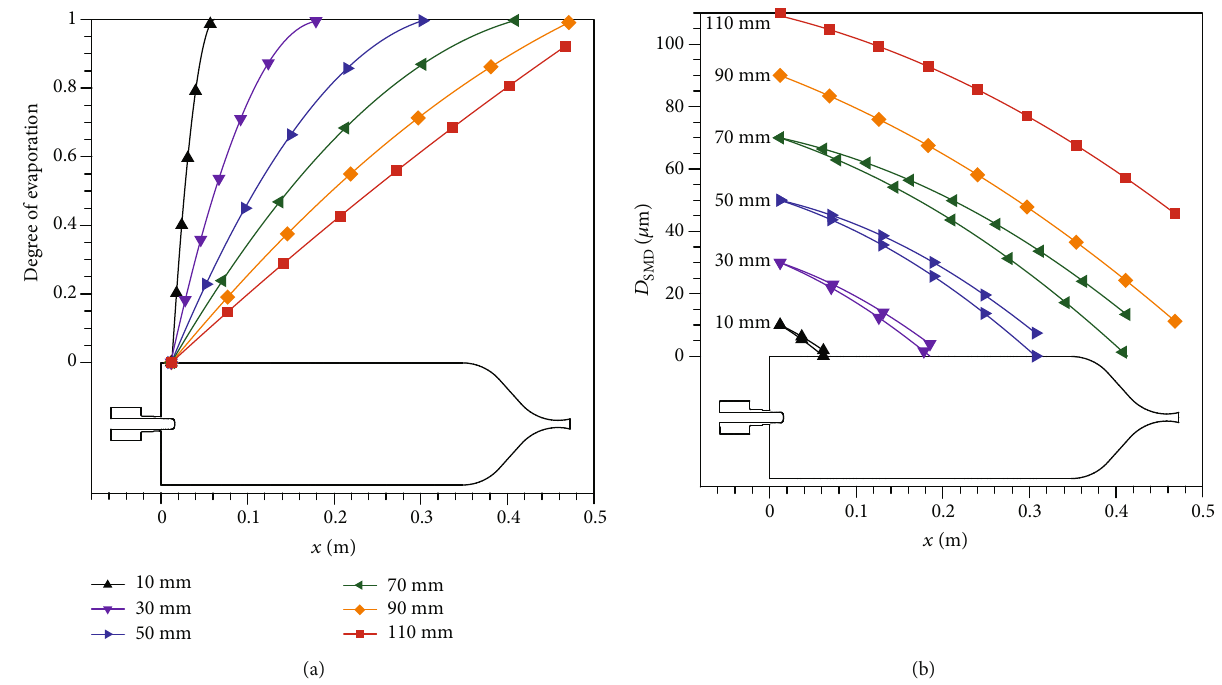
ff erent initial particle diameters. SMD (b) versus the combustor axis for di